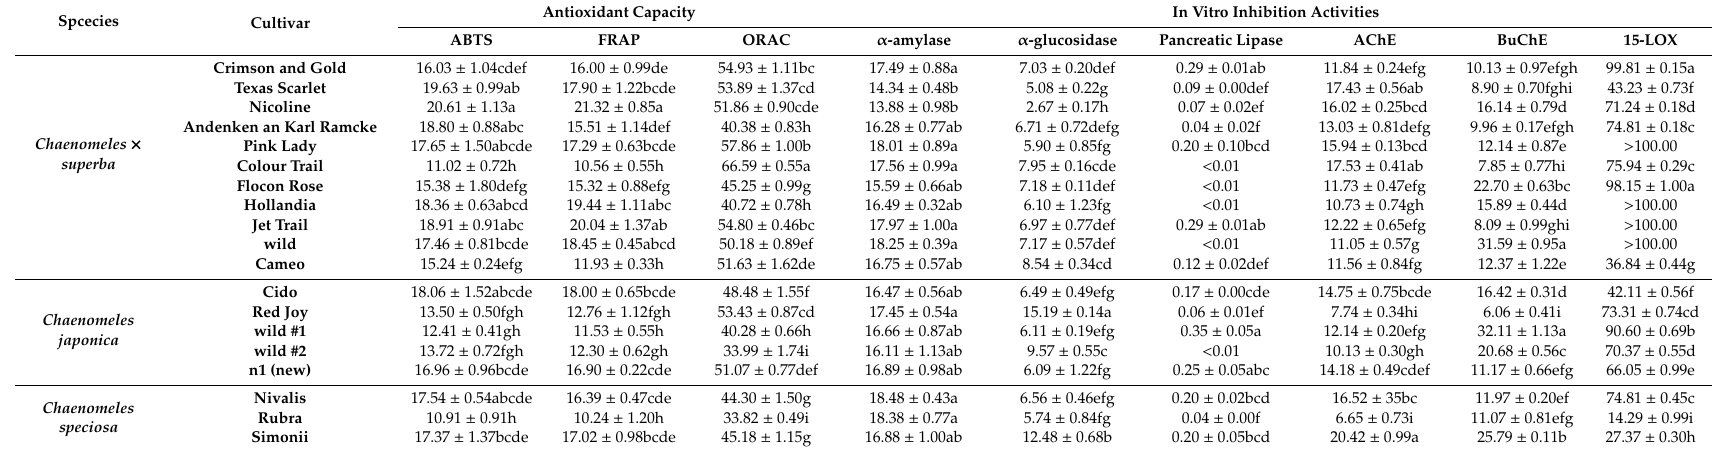
Table 4. Antioxidant (mmol Trolox / 100 g dw), α -amylase, α -glucosidase, pancreatic lipase, acetylcholinesterase, butyrylcholinesterase (IC 50 , mg / mL),and 15-lipoxygenase inhibitionactivity (% of inhibition) of various species and cvs. of Chaenomeles fruits.